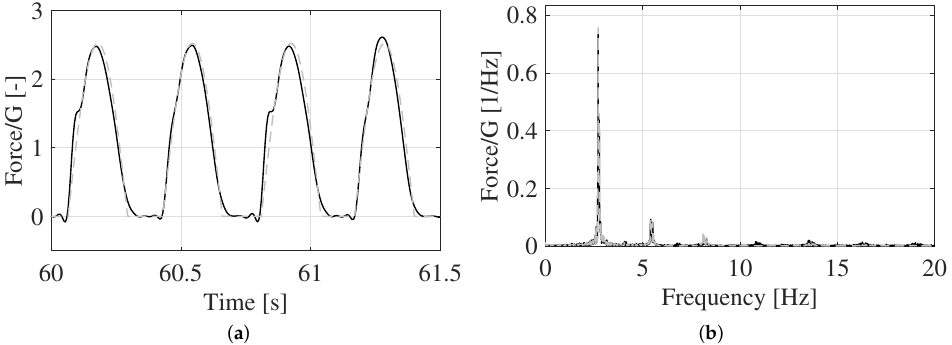
Figure 7. The load induced by participant 1 during test 1, measured forces (black), reconstructed using the method described in Section 2.2 and single-step load pattern model 1 (gray): ( a ) time series and ( b ) amplitude